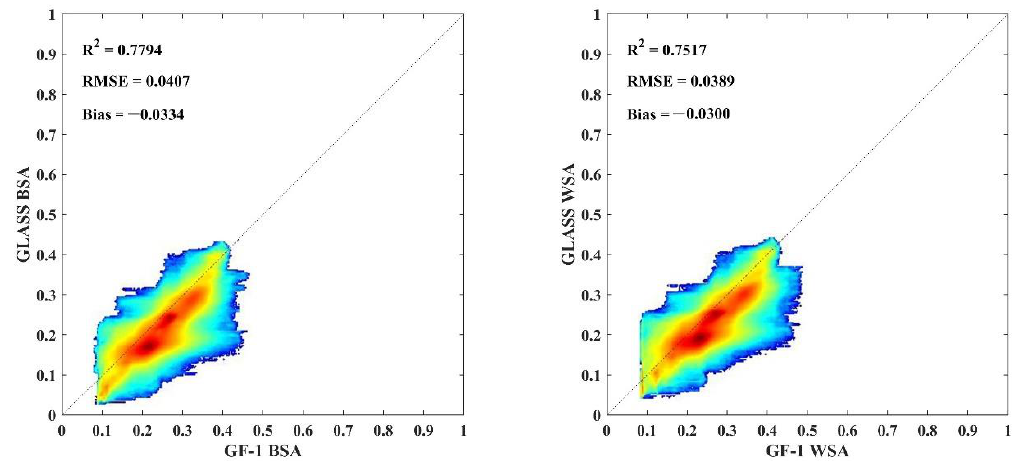
Figure 13. Scatter plot of the GF-1 albedo and GLASS albedo in